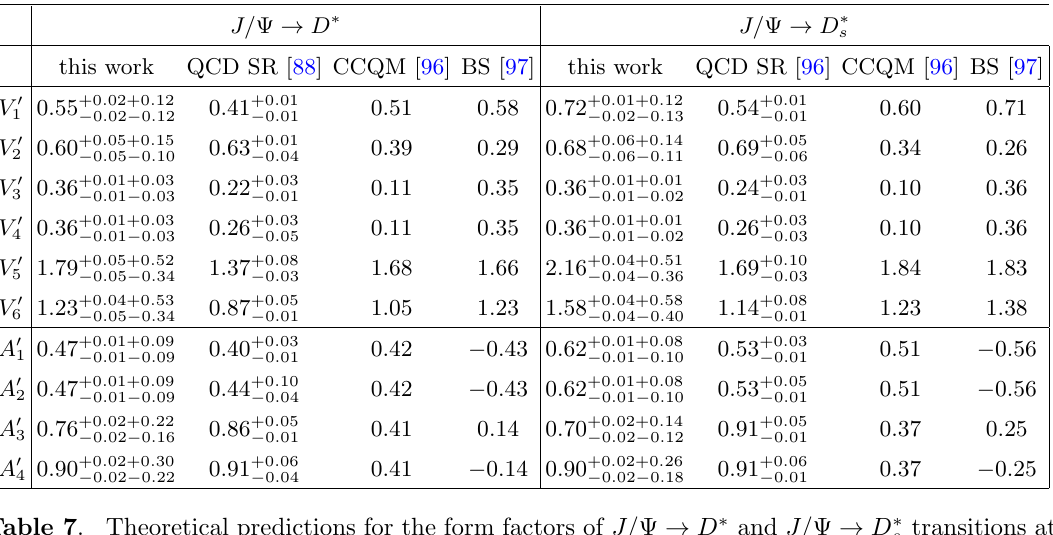
Table 7 . Theoretical predictions for the form factors of J= (cid:9) ! D (cid:3) and J= (cid:9) ! D (cid:3) q 2 = 0 in this work, QCD SR [88], CCQM [96] and BS method [97].